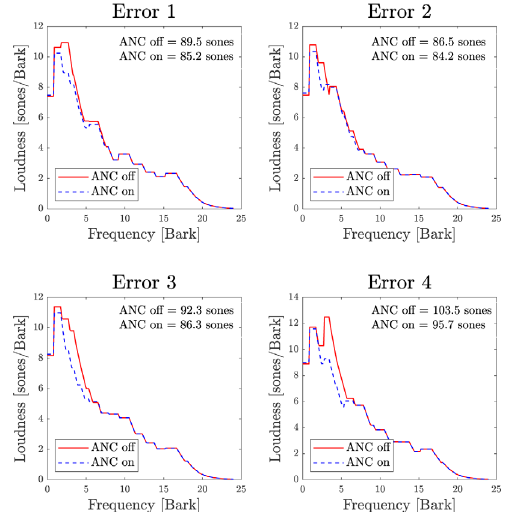
Figure 12. Speci fi c loudness trend calculated according to ISO 532-1 for signals at the 4 error microphone locations. The top right box in each plots indicates the overall loudness values calculated in the two conditions – red solid line ANC off, blue dashed line ANC on.